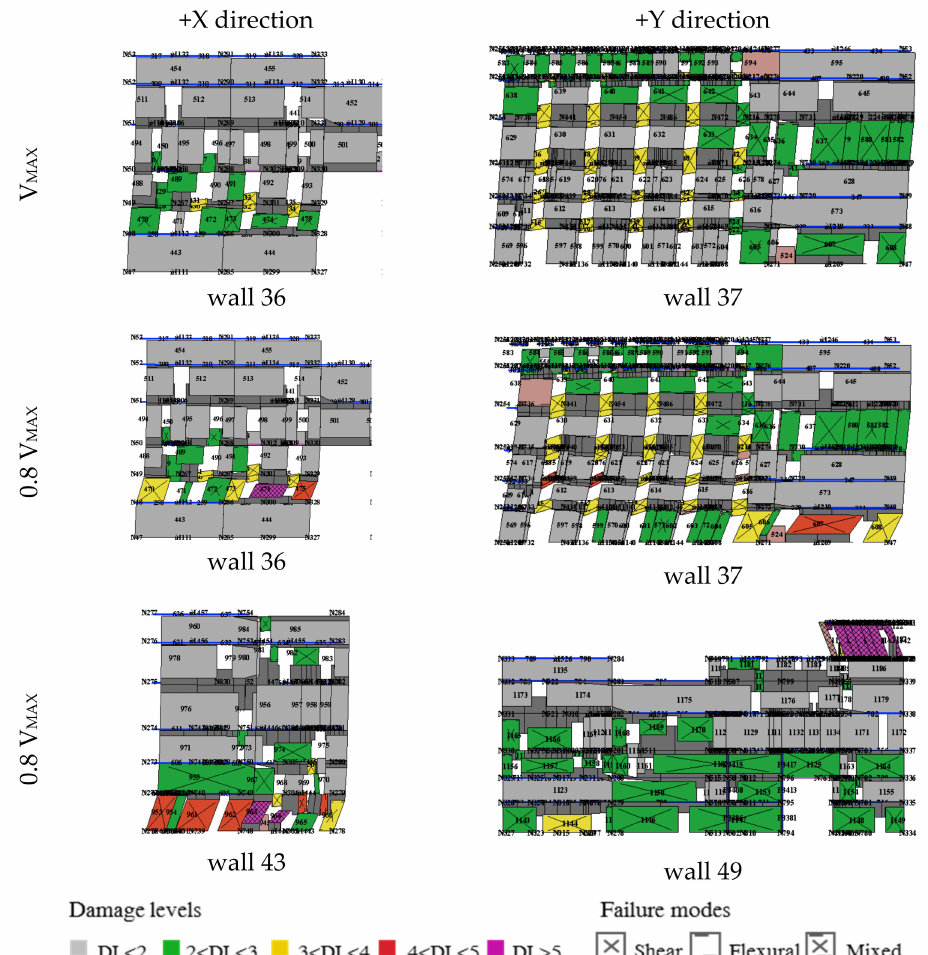
Figure 11. Damage pattern of some walls in the Podest à Palace (uniform LP